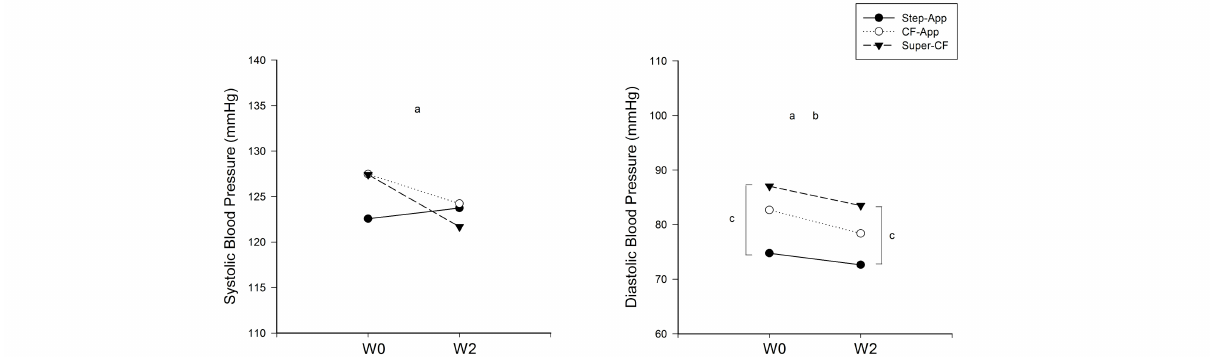
Figure 4. Baseline (W0) and 2 weeks (WL2) systolic and diastolic blood pressure changes induced by the interventions. Step-APP, 10,000 steps/day training plan provided by a smartphone application; CF-App, ACSM guidelines-based cardio-fitness training plan provided by a smartphone application; Super-CF, ACSM guidelines-based cardio-fitness training plan provided by a personal trainer. a, Significant main effect of time. b, Significant main effect of group. c, Significant difference between Step-App group and Super-CF